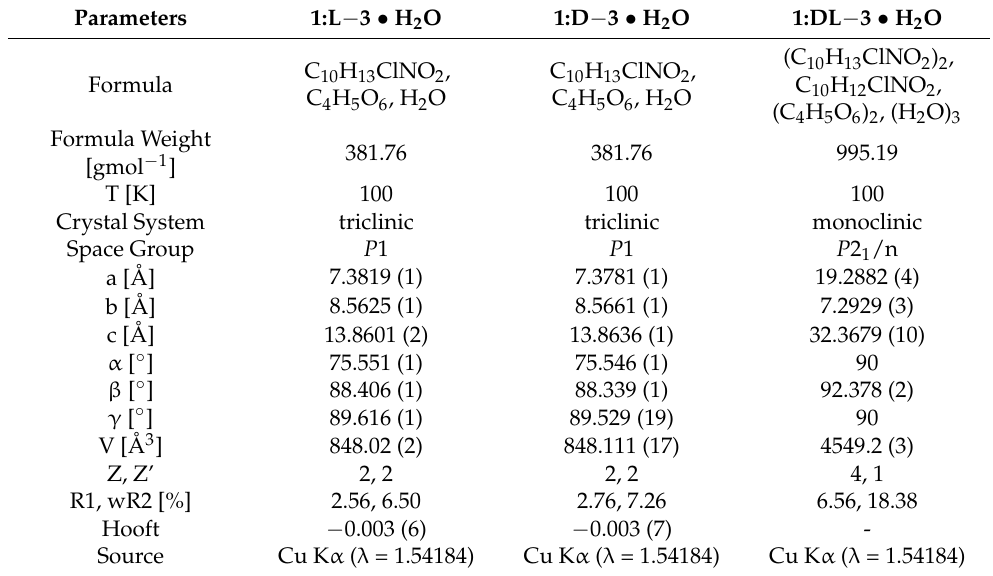
Table 3. Crystallographic data obtained by SCXRD measurements of 1:L − 3 • H 2 O , 1:D − 3 • H 2 O and 1:DL − 3 • H 2 O .